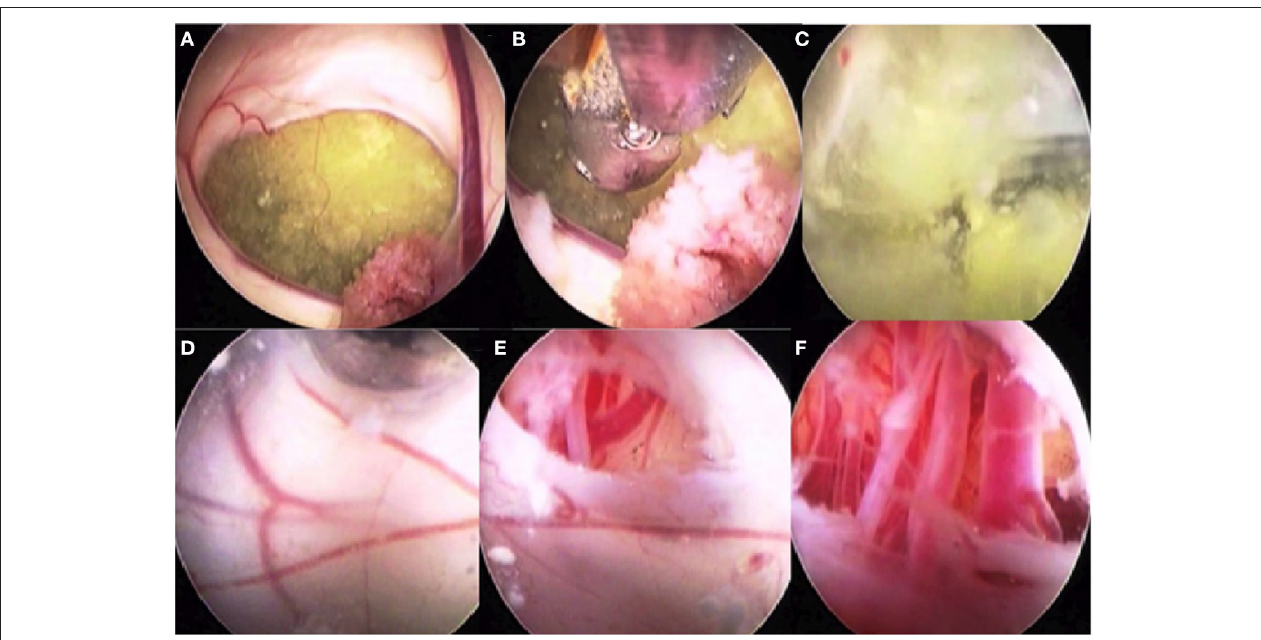
FIGURE 8 | Intraoperative images of a patient with a cystic intraventricular craniopharyngioma undergoing endoscopic cyst fenestration and third ventriculostomy. (A) Intra-third ventricular craniopharyngioma cyst seen through foramen of Monro. Choroid plexus is also seen. (B) The cyst is being fenestrated using an endoscope through the frontal, transcortical, transforaminal approach. (C) The machinery oil fluid of the craniopharyngioma cyst is well seen. (D) The inner wall of the craniopharyngioma cyst blended with the third ventricular ependymal floor is seen after drainage of the cyst contents. The cyst wall along with the third ventricular floor is being fenestrated. (E) The arterial blood vessels in the interpeduncular cistern are visible. (F) The endoscope tip is taken through the inferior cyst wall and the ventricular ependyma to see the blood vessels of the interpeduncular